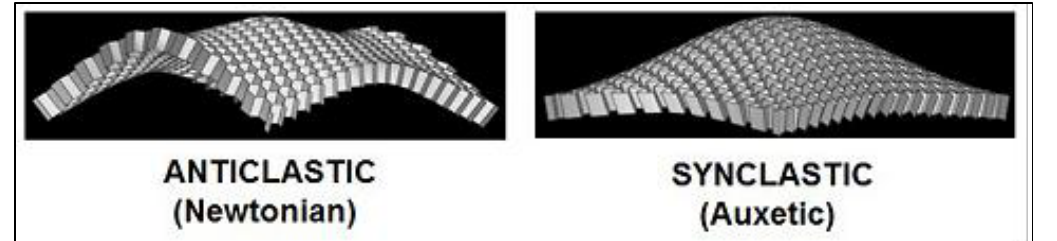
Figure 8. Curvature of a Newtonian and of an auxetic cellular